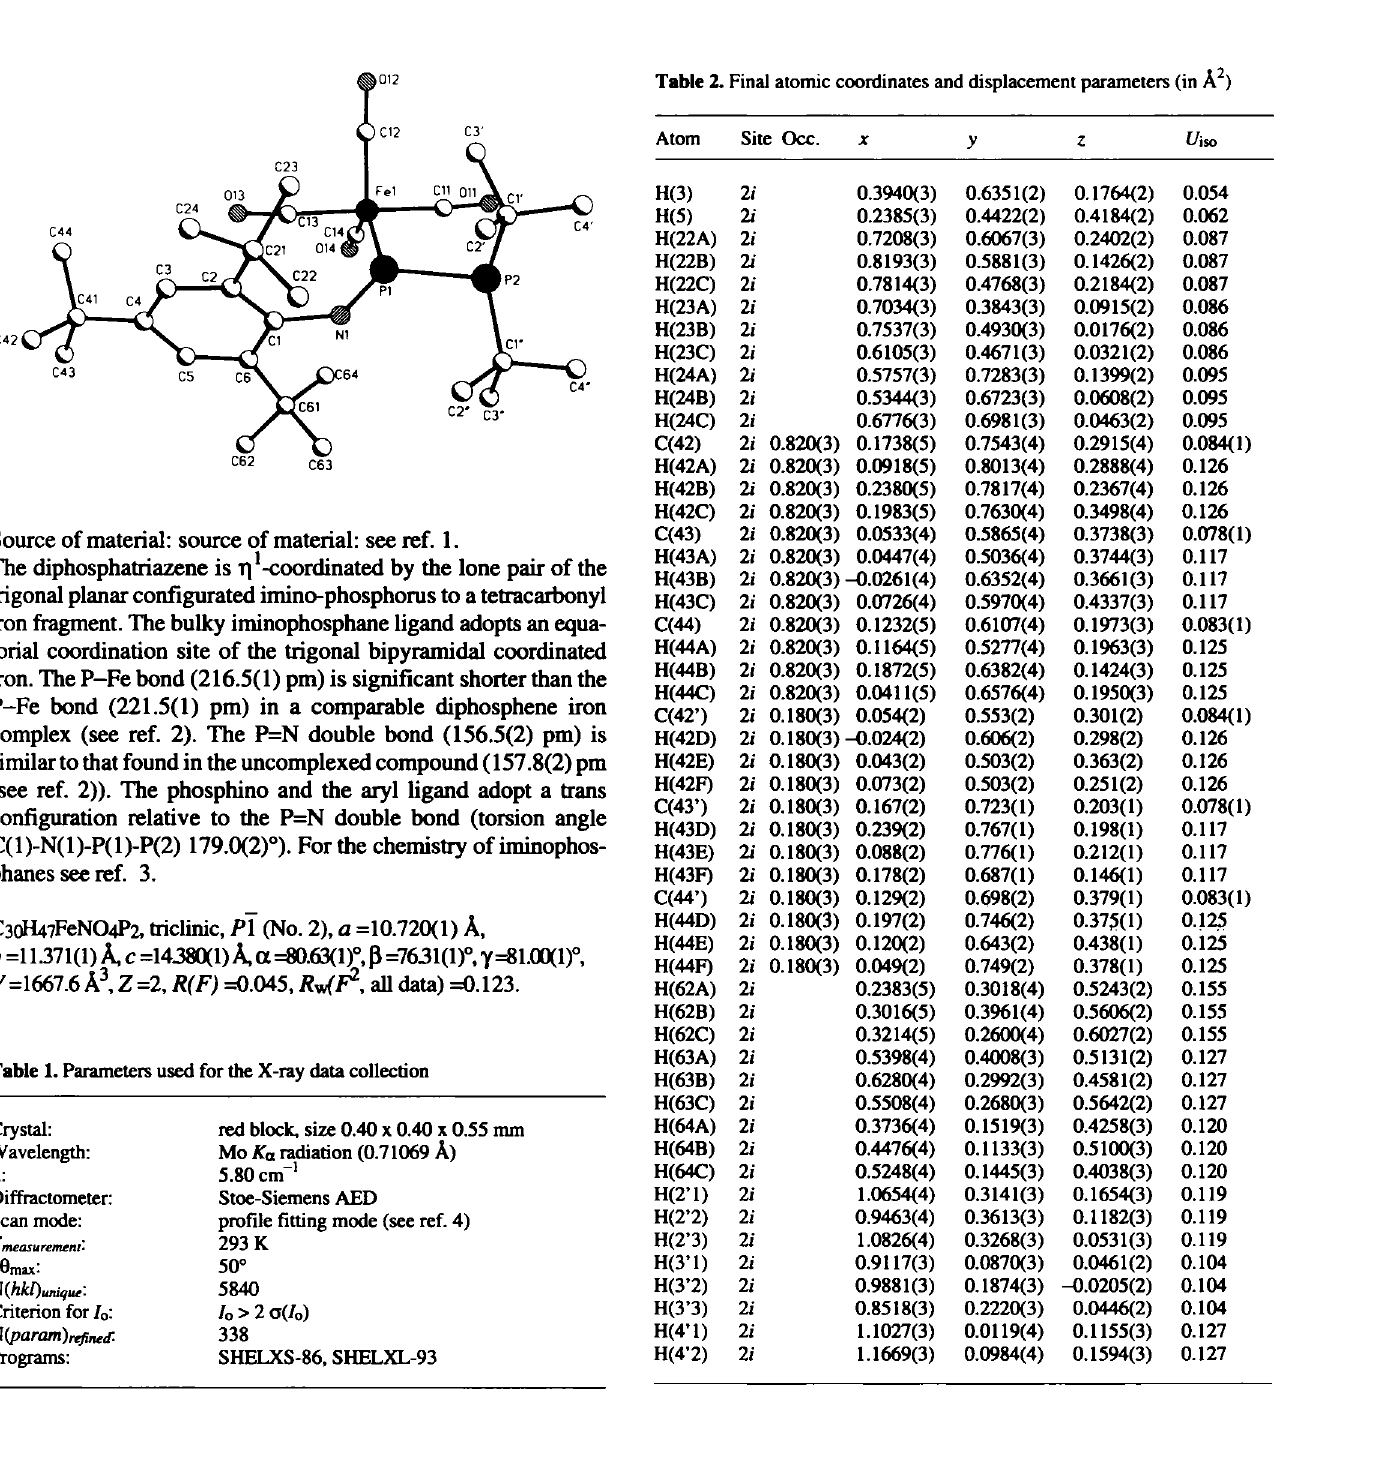
Table 2. Final atomic coordinates and displacement parameters (in Â 2 )